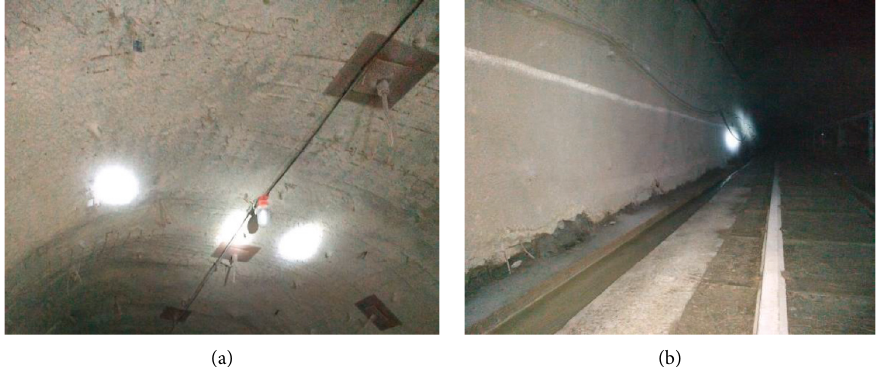
Figure 10: Support effect of the return-air roadway: (a) support effect of the roof and (b) support effect of the sidewall.